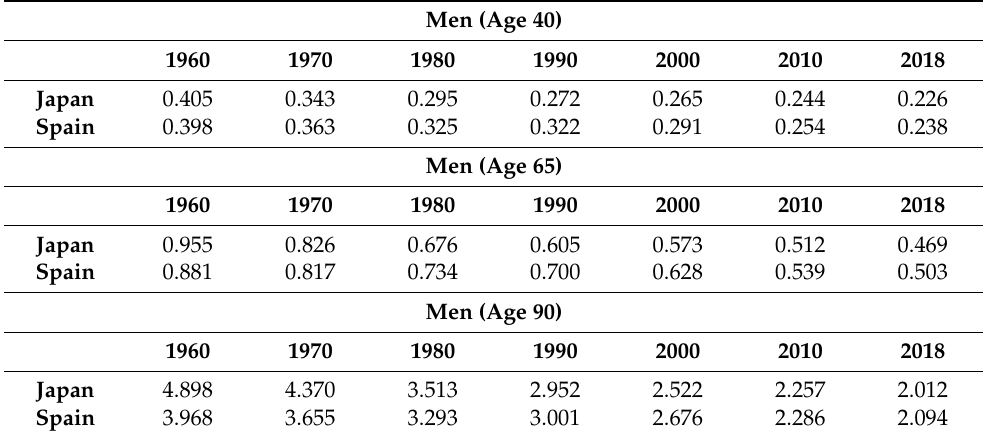
Table 4. Entropy values for the male population for Japan and Spain, for three specific ages: 40, 65, and 90 years old, and for different calendar dates.